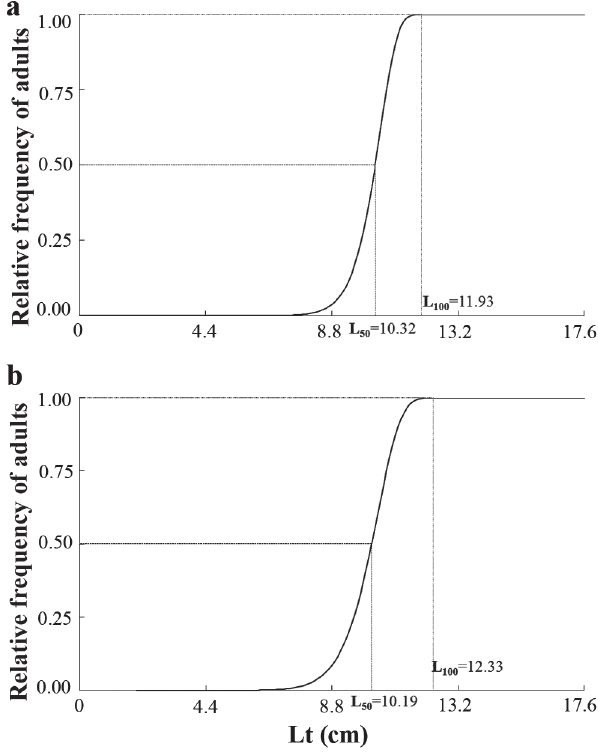
Fig. 8. First maturation length for females ( a ) and males ( b ) of Etropus crossotus in the shallow infralittoral areas of the Paranaguá Estuarine Complex. L = the shortest total length 50 (Lt), in which 50% of the individuals sampled were adults. L = the shortest total length (Lt), in which 100% of the 100 individuals sampled were adults. Female amostral N = 171, and male amostral N =